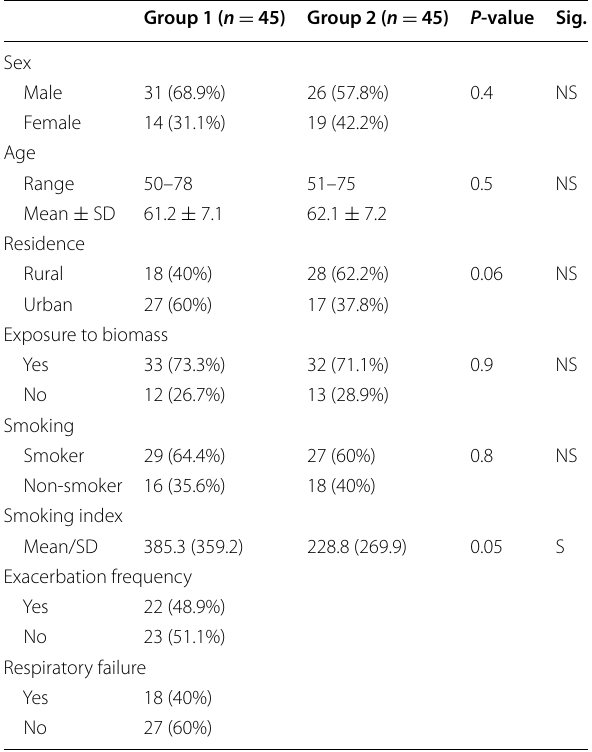
Table 1 Demographic features of 45 patients and 45 controls under study